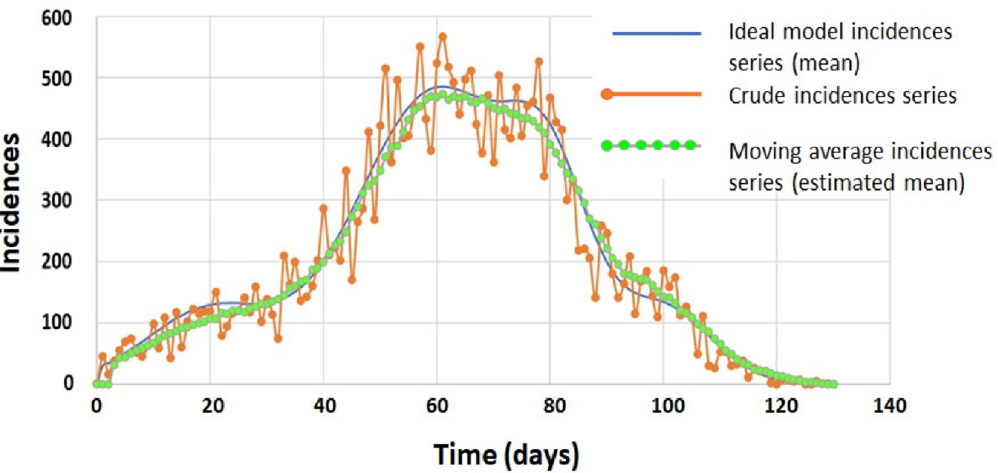
Figure 7. Crude I t incidence series (orange-zigzag), ideal model incidence (blue-smooth), and moving average incidence (green-smooth dotted). The I t incidence series was generated with the random incidence series generator. All curves are synchronized.